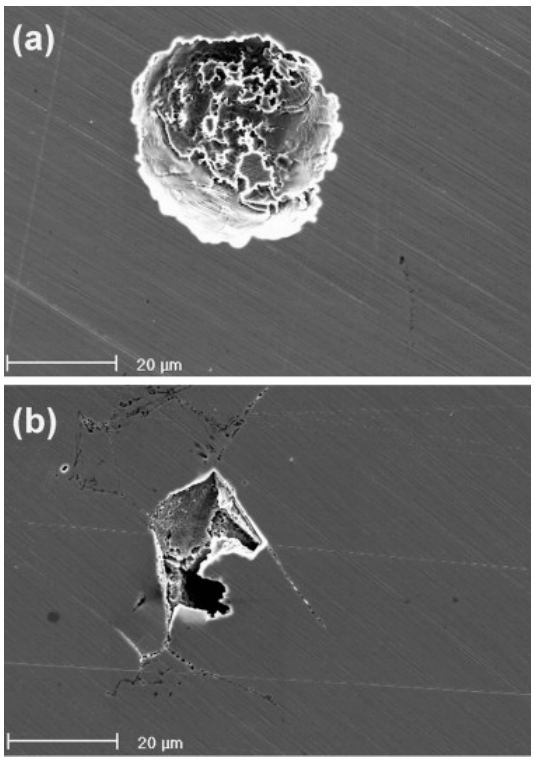
Figure 19. SEM micrographs showing surface pit in: ( a ) 49% cold worked non-sensitized specimen, and ( b ) 49% cold worked and sensitized specimen after potentiodynamic polarization in a 3.5% NaCl solution [122]. (Reproduced with permission from refs. [122]. Copyright (2009), Elsevier).